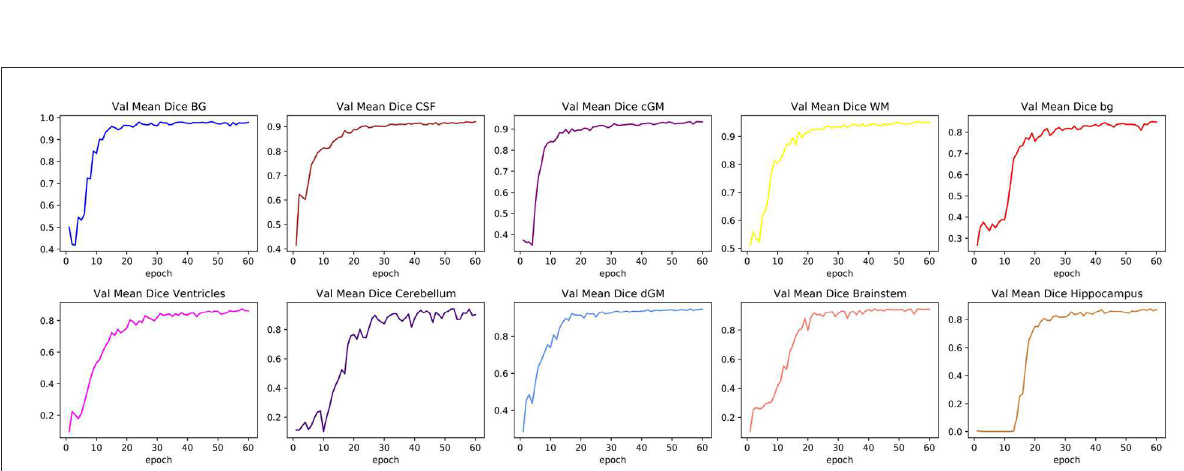
In other words, two-thirds of the slices along the respective axis were hidden from the model during training. To